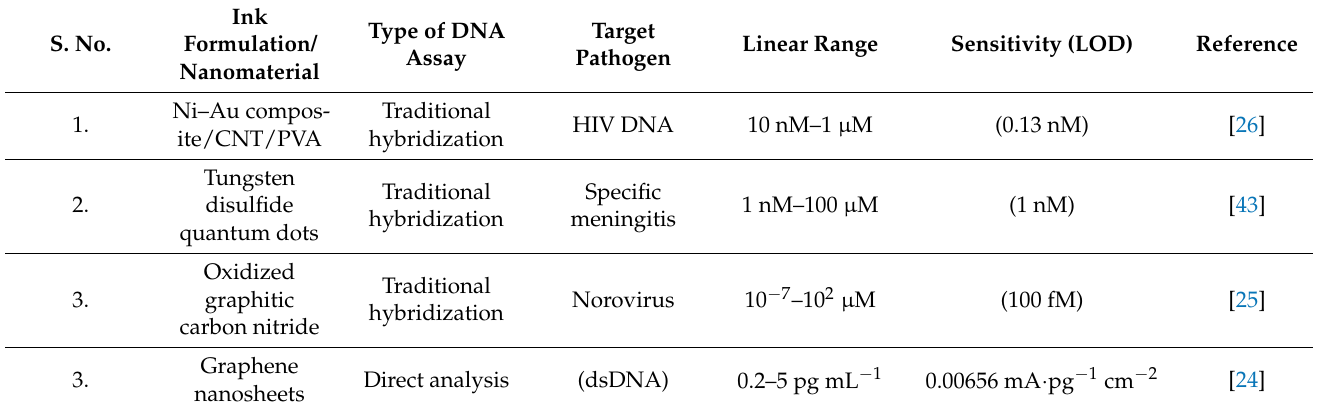
Table 2. Comparison of recent studies on paper-based biosensors for DNA detection.